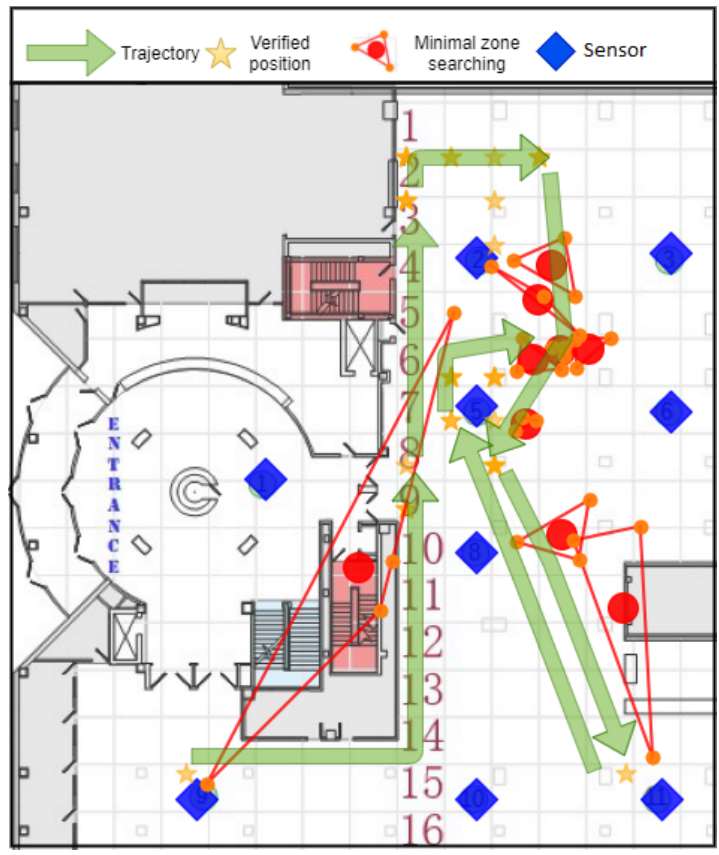
Figure 8. MZS algorithm applied to DS1